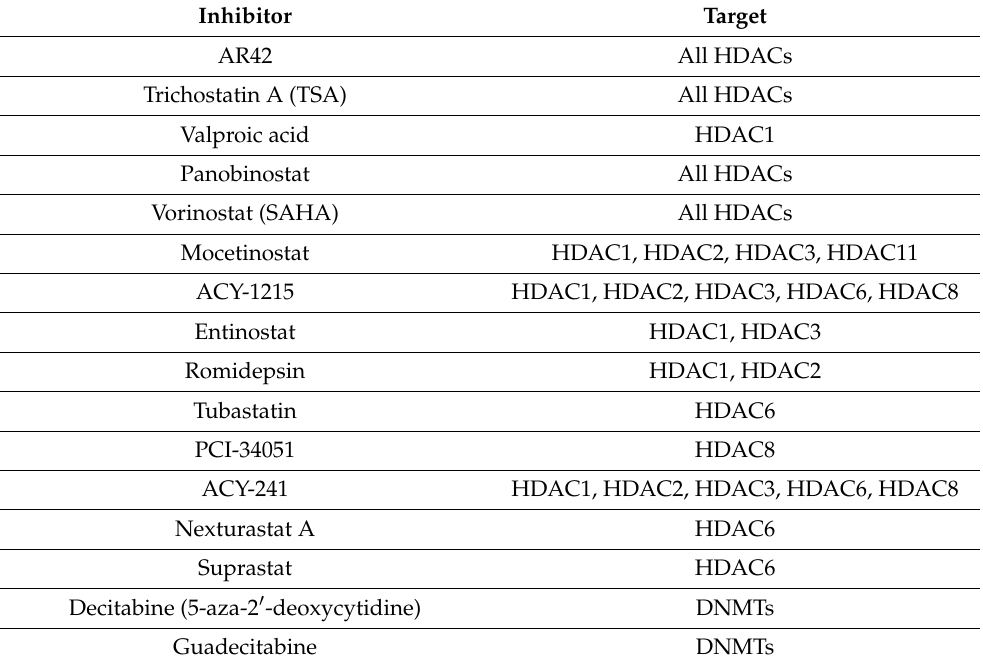
Table 2. Specificity of epigenetic drugs discussed throughout this review